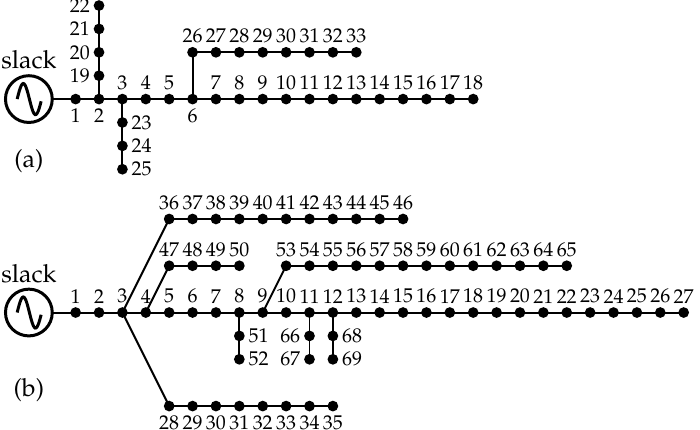
Figure 2. Electrical configuration of the test feeders: ( a ) IEEE 33-node system and ( b ) IEEE 69-bus system.